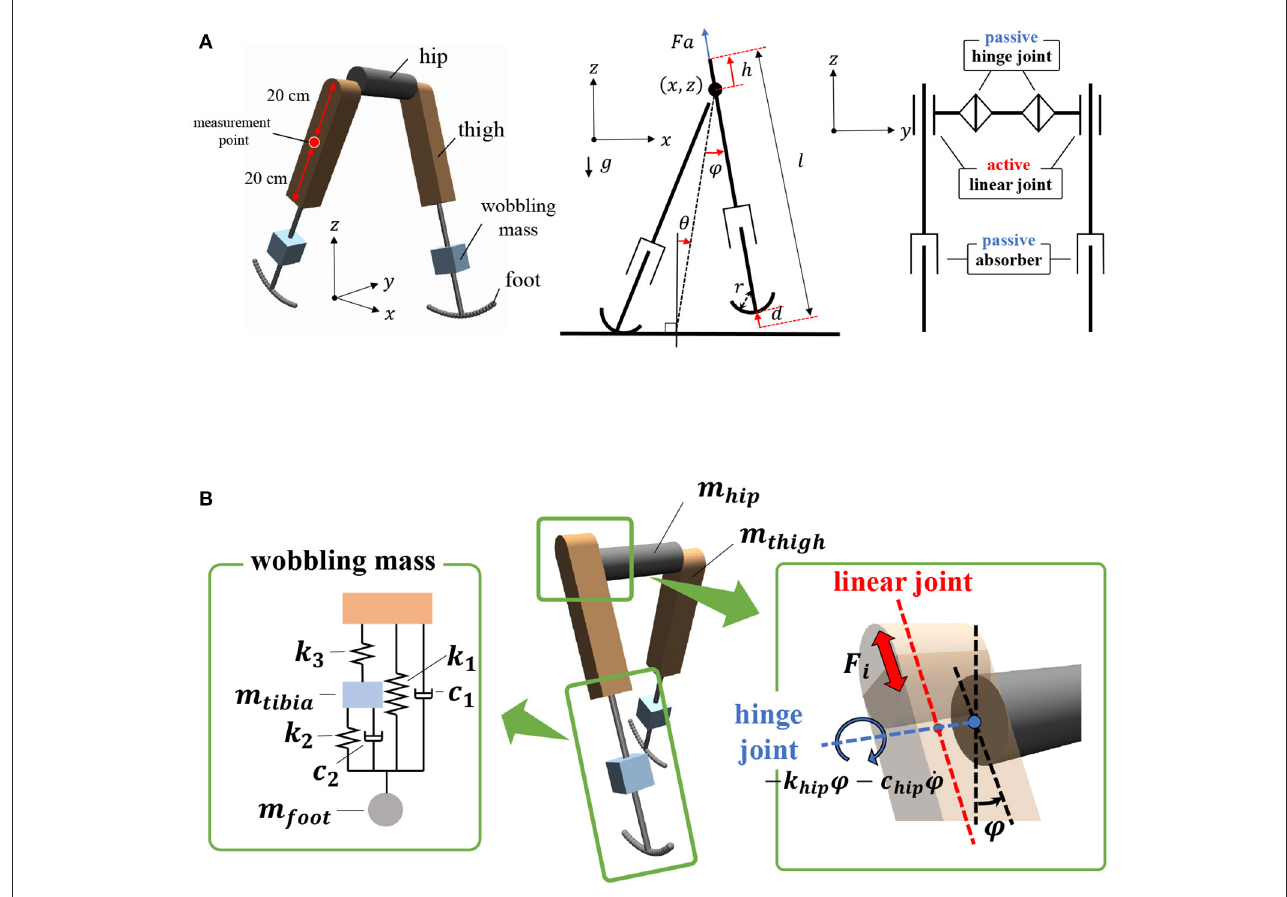
FIGURE1 Structure of the bipedal model. The motions are constrained in the x – z plane, i.e., the sagittal plane. (A) Left: Oblique view of the bipedal model in MuJoCo simulator. Center: Side view of mechanical structure of the model. Right: Front view of mechanical structure. (B) Left: Schematic of wobbling mass mechanism. Right: Active linear actuators and passive rotational springs were implemented to thigh segments and hip joints, respectively.